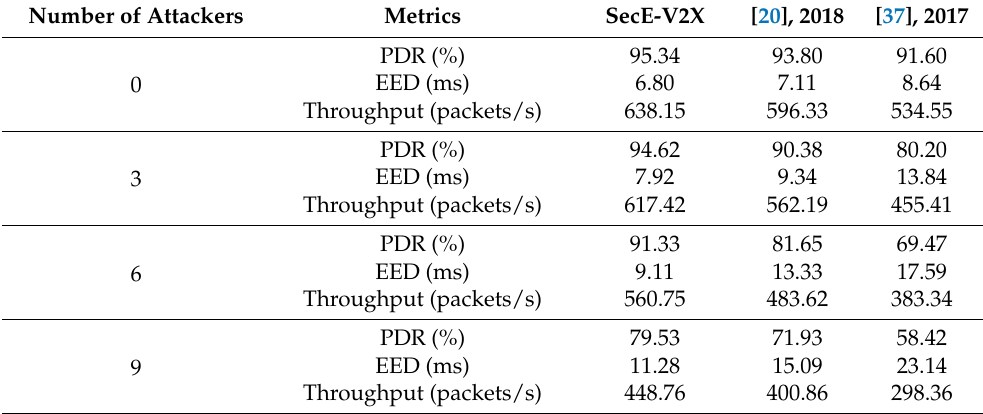
Table 6. Performance values comparison under Jellyfish delay variance attacks.